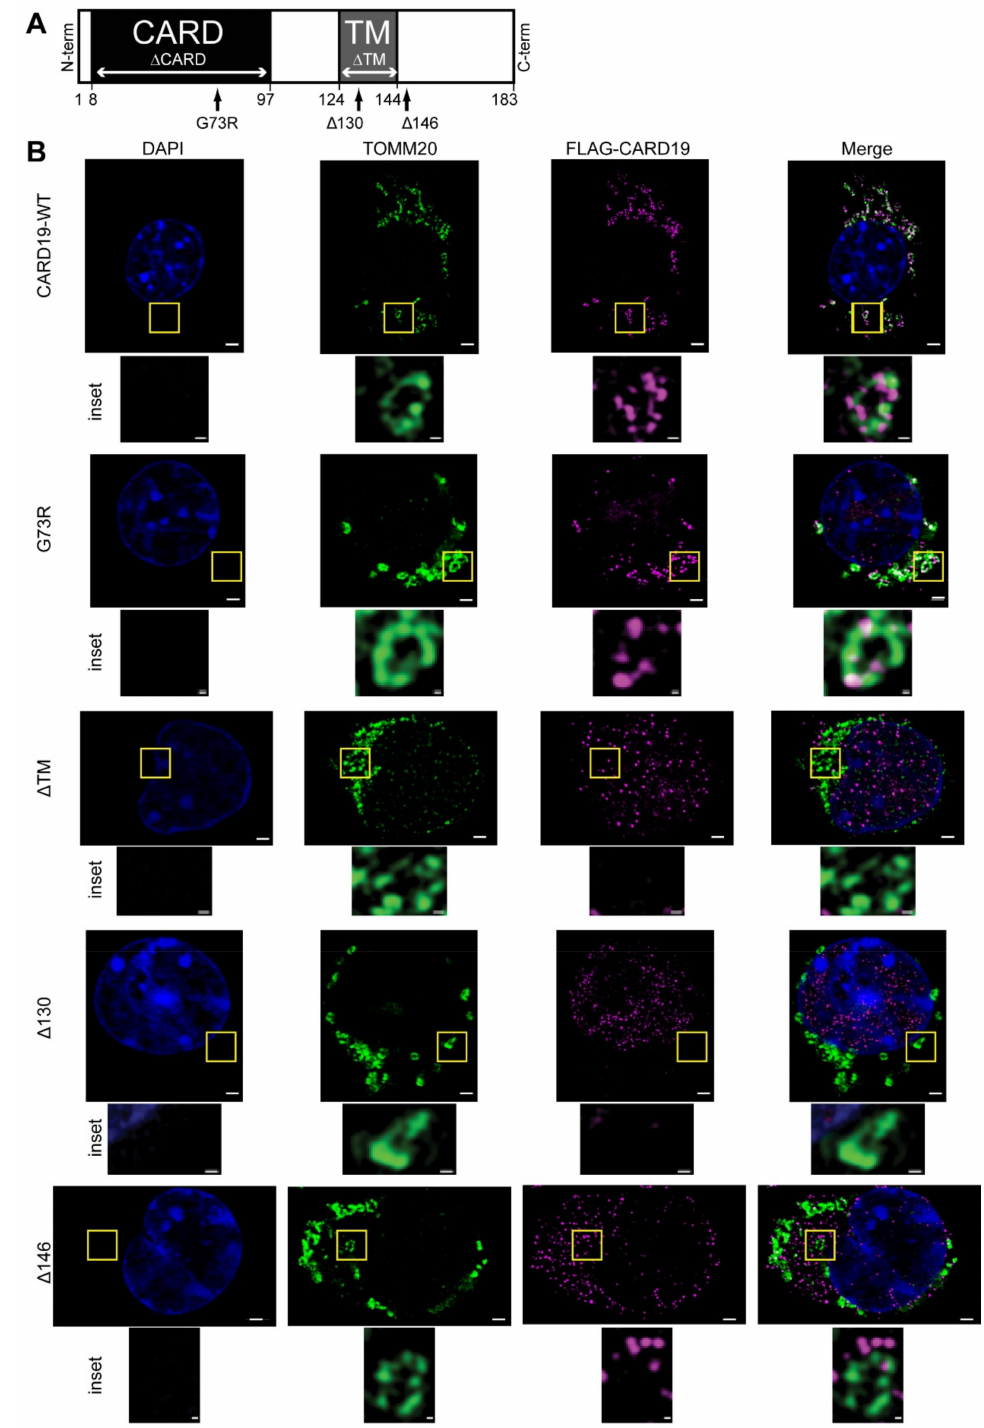
Figure 2. The CARD19 transmembrane domain and distal C-terminus are required for mitochondrial localization. ( A ) Diagram of CARD19 protein, with locations of domains, domain boundaries and mutations. The CARD and transmembrane domain (TM) are shaded. Point mutations and deletions are indicated by arrows. ( B ) Card19 − / − immortalized macrophages ectopically expressing FLAG- tagged WT and mutant forms of CARD19 were labeled with anti-FLAG and anti-TOMM20 and imaged via SIM. Insets contain individual mitochondria. Scale bars correspond to 5 µ m in full images and 0.2 µ m in